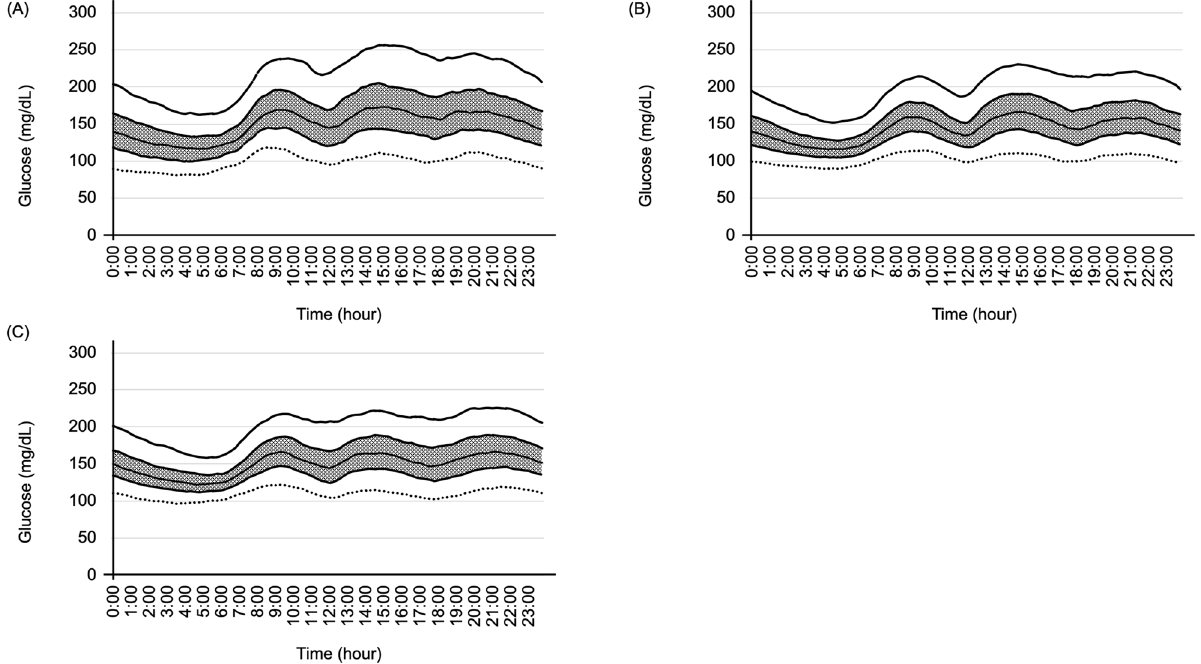
Figure 2. Mean glucose profile of patients in the three C-peptide subgroups: ( A ) low C-peptide (CPR < 1 ng/ mL, n = 62), ( B ) moderate C-peptide (1 ng/mL ≤ CPR < 2 ng/mL, n = 113) and ( C ) high C-peptide (CPR ≥ 2 ng/ mL, n = 109). Smoothed curves represent the 10th (fine dotted line), 25th (dotted line), median (50th, solid line), 75th (broken line), and 90th (thick dotted line) frequency percentiles. Unstable glucose variability appears to be present in the low C-peptide subgroup.